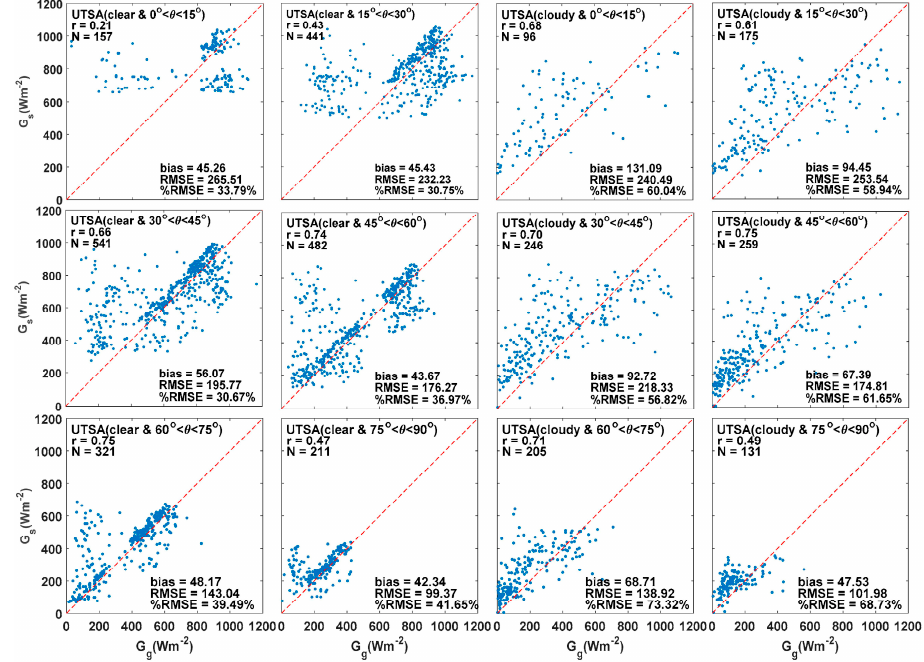
Figure 8. Scatter plots showing the comparisons of G s with G g for various intervals of solar zenith angle for clear-sky ( left two panels ) and cloudy-sky ( right two panels ) conditions, respectively at the UTSA site.